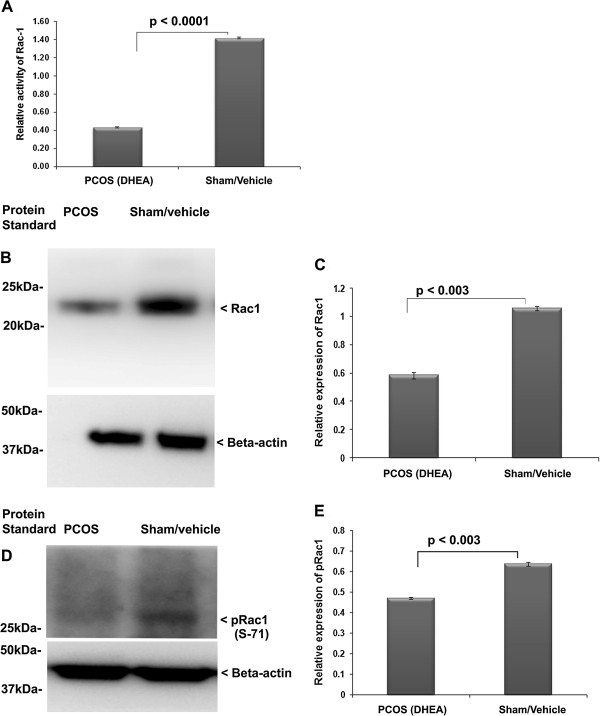
Determination of expression and activity of Rac1 in DHEA induced PCOS ovary. Relative activity of Rac1 was analyzed in the DHEA (PCOS) and sham treated ovary (A). Expression level analysis of Rac1 was determined by immuno-blotting and densitometry in the ovary of PCOS and sham (B and C). The activity Rac1was assayed by analysis of its phosphorylated form (D and E).